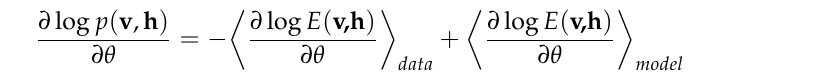
Figure 3. The CD- k learning procedure. To estimate data and alternately sample the hidden and then the visible units. The observed value of v i h j at the ( N + 1 ) st sample is used as the